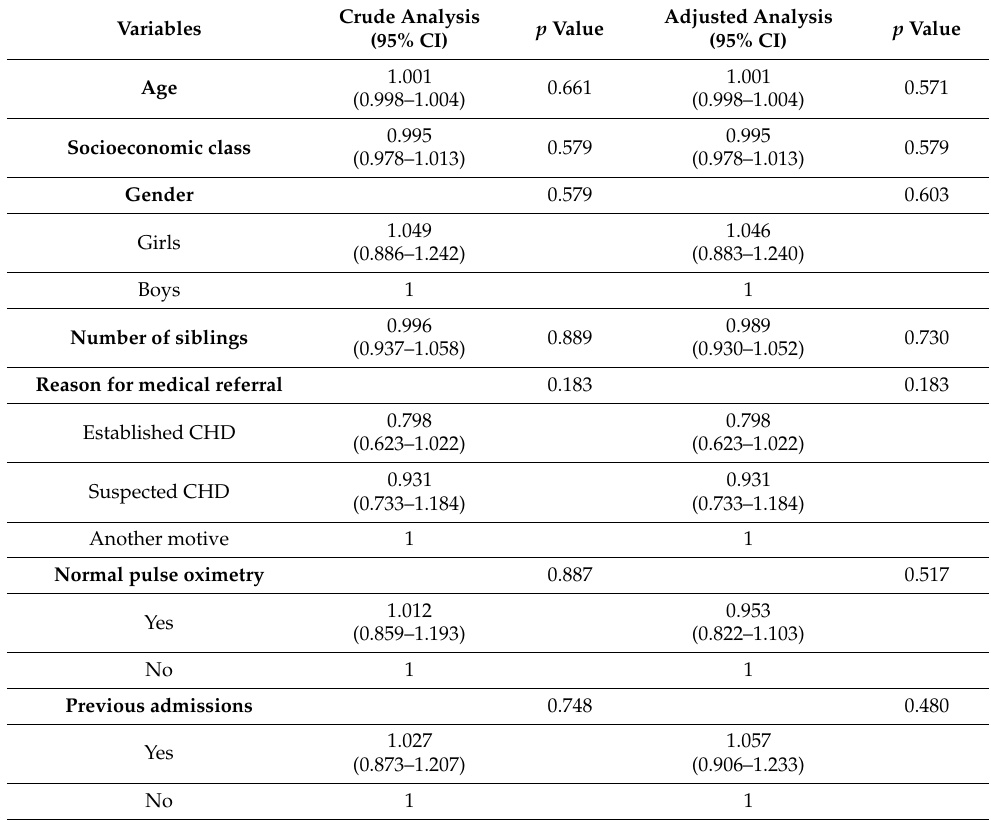
Table 3. Crude and adjusted analysis of risk factors related to motor